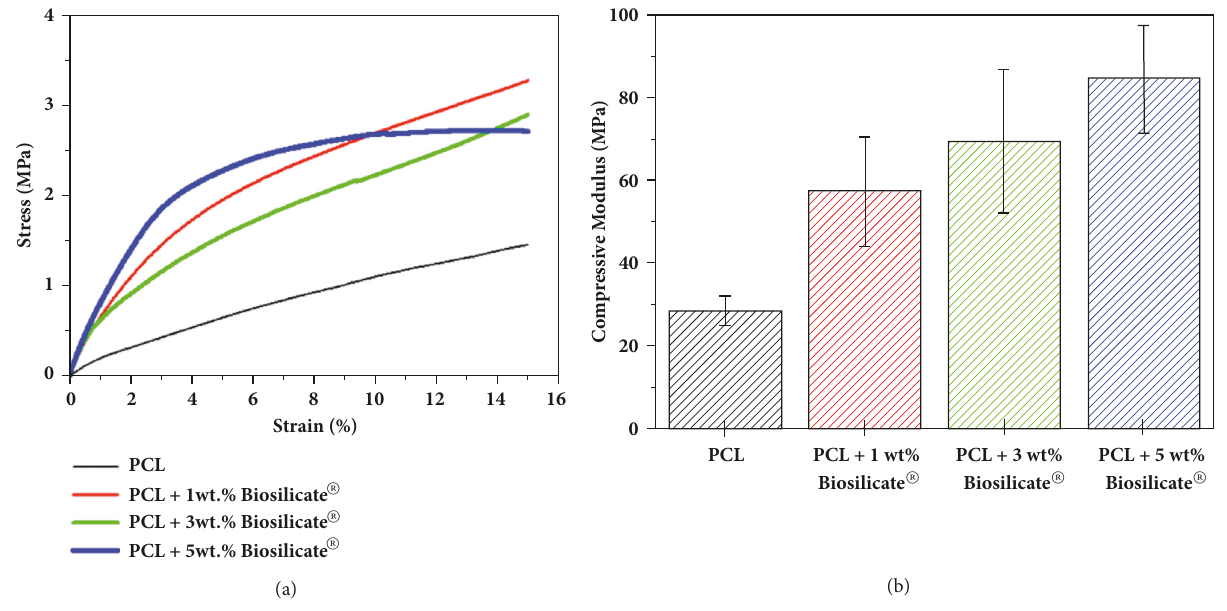
Figure 5: (a) Average stress-strain curves and (b) compressive modulus of PCL, PCL + 1, 3, and 5 wt.% Biosilicate (cid:2)